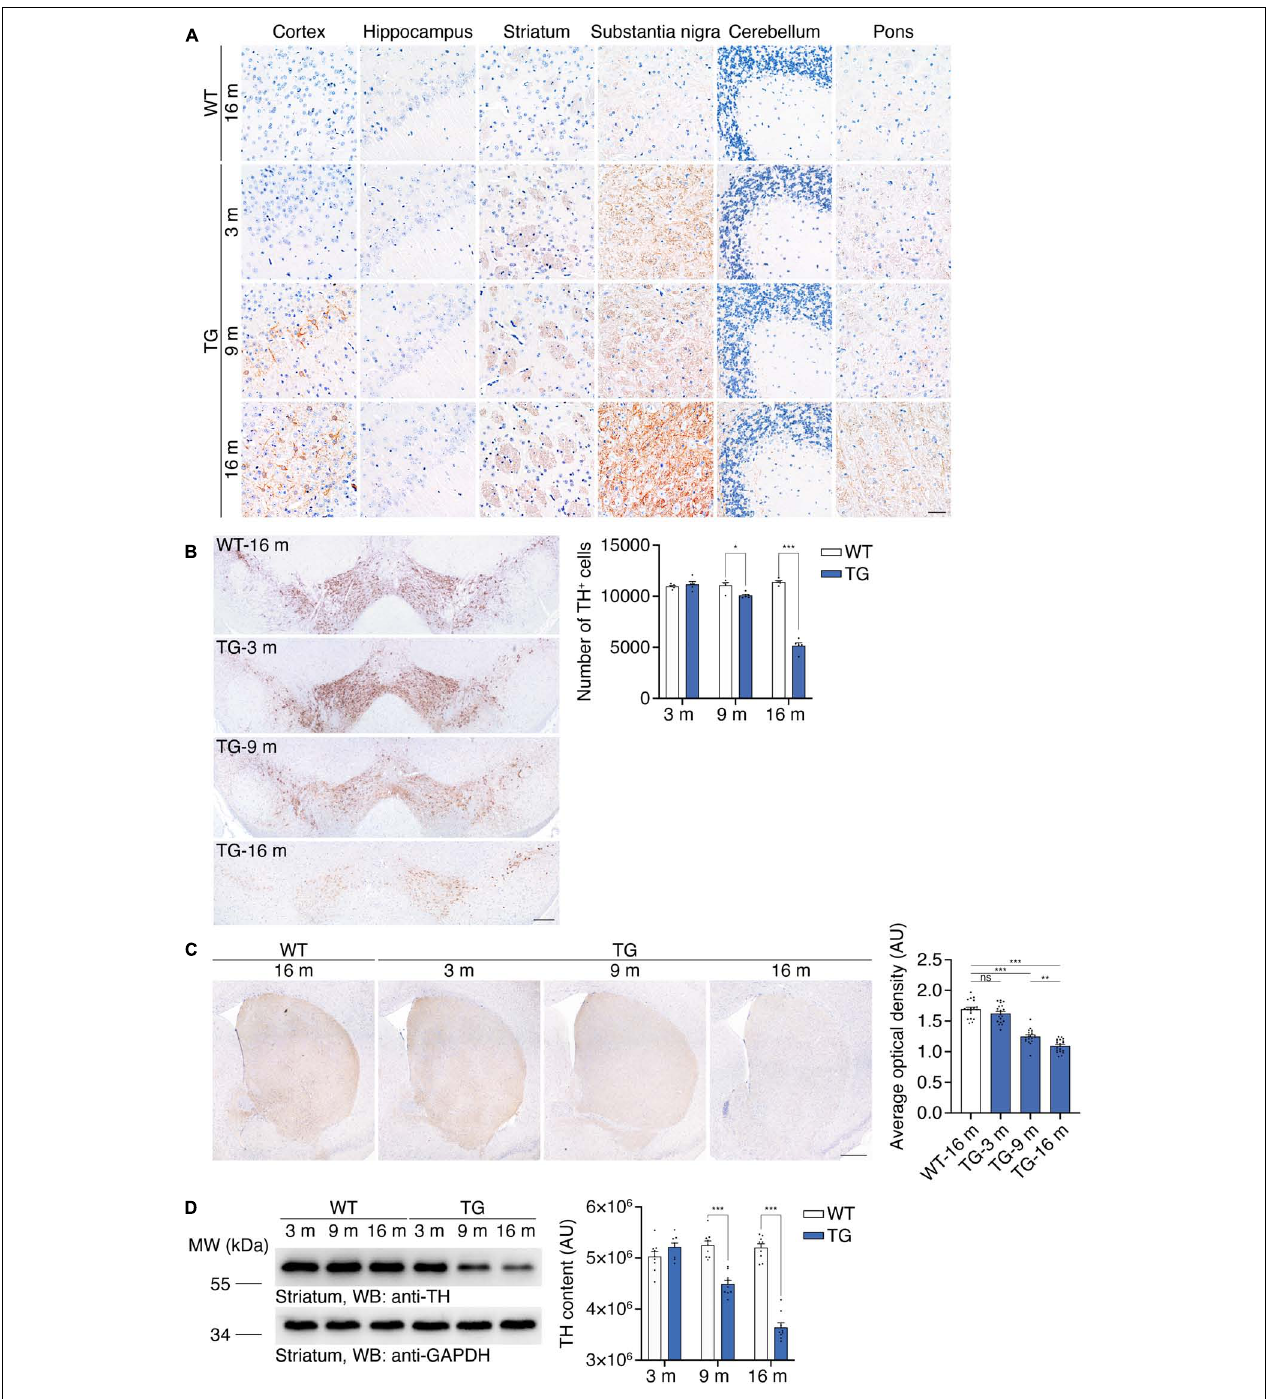
FIGURE 3 | Accumulation of α -synuclein p-S129 and nigrostriatal pathway degeneration in N103 mice. (A) Immunohistochemistry of α -synuclein p-S129 in the cortex, hippocampus, striatum, substantia nigra, cerebellum, and pons in WT mice and N103 mice. Scale bar, 40 µ m. (B) Unbiased stereological cell counting of the substantia nigra by anti-TH immunostaining. Scale bars, 200 µ m. Bar graph, quantification of the TH-positive neurons. Data are mean ± s.e.m.; n = 5 mice per group; * P < 0.05 and *** P < 0.001 by two-way ANOVA and Bonferroni’s multiple comparisons. (C) TH immunostaining of striatum. Scale bars, 400 µ m. Bar graph, quantification of the average optical density (expressed as arbitrary units). Data are mean ± s.e.m.; n = 5 mice per group; ** P < 0.01 and *** P < 0.001 by one-way ANOVA and Tukey’s multiple comparisons. (D) Western blots showing the striatal TH content in WT mice and N103 mice. Bar graph, quantification of the integrated optical intensity (expressed as arbitrary units). Data are shown as mean ± s.e.m.; n = 9 mice per group; *** P < 0.001 by two-way ANOVA and Bonferroni’s multiple comparisons.